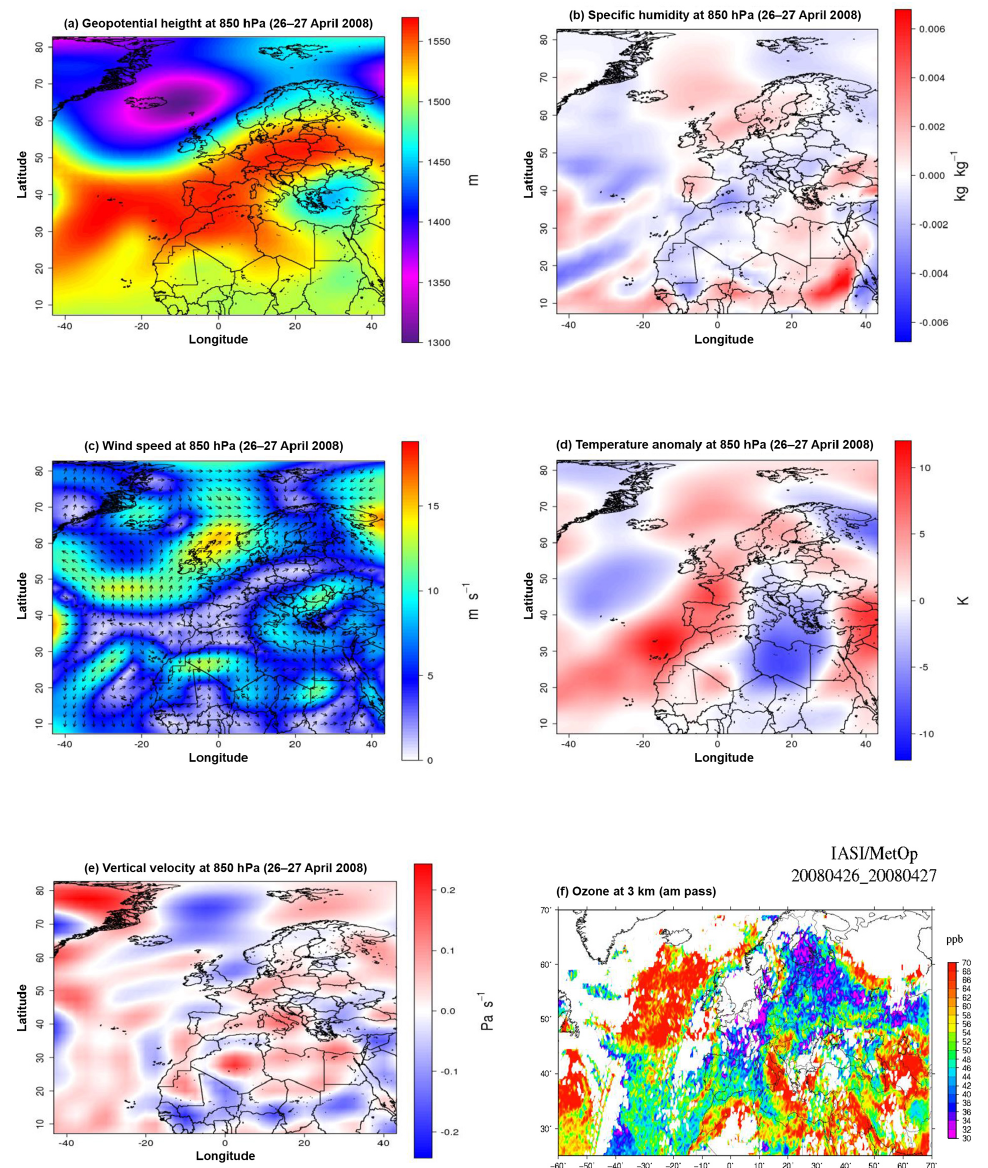
Figure 2. Composite NOAA/ESRL weather maps of geopotential height ( a ; in m), specific humidity anomaly ( b ; in KgKg − 1 ), vector wind ( c ; in ms − 1 ), air temperature anomaly ( d ; in K), omega vertical velocity ( e ; in Pas − 1 ) and IASI satellite ozone-mixing ratios at 3km ( f ; in ppb) for the high ozone episode of 26–27 April